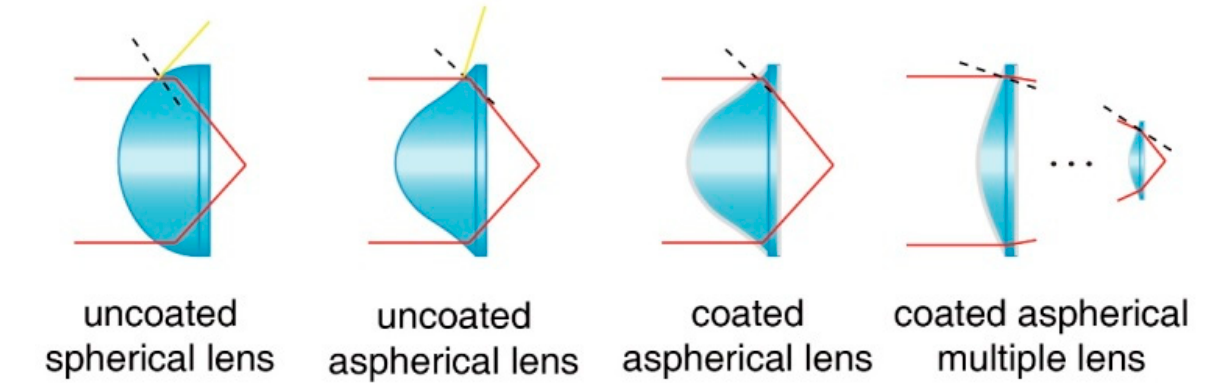
Figure 2. Four designs used in high-NA lens systems. The red solid lines show the light paths, the yellow solid lines show the reflection light paths of the interface surface, the black dotted lines show the normal lines of the interface, and the coated lenses are represented by the gray boundary on the surface.